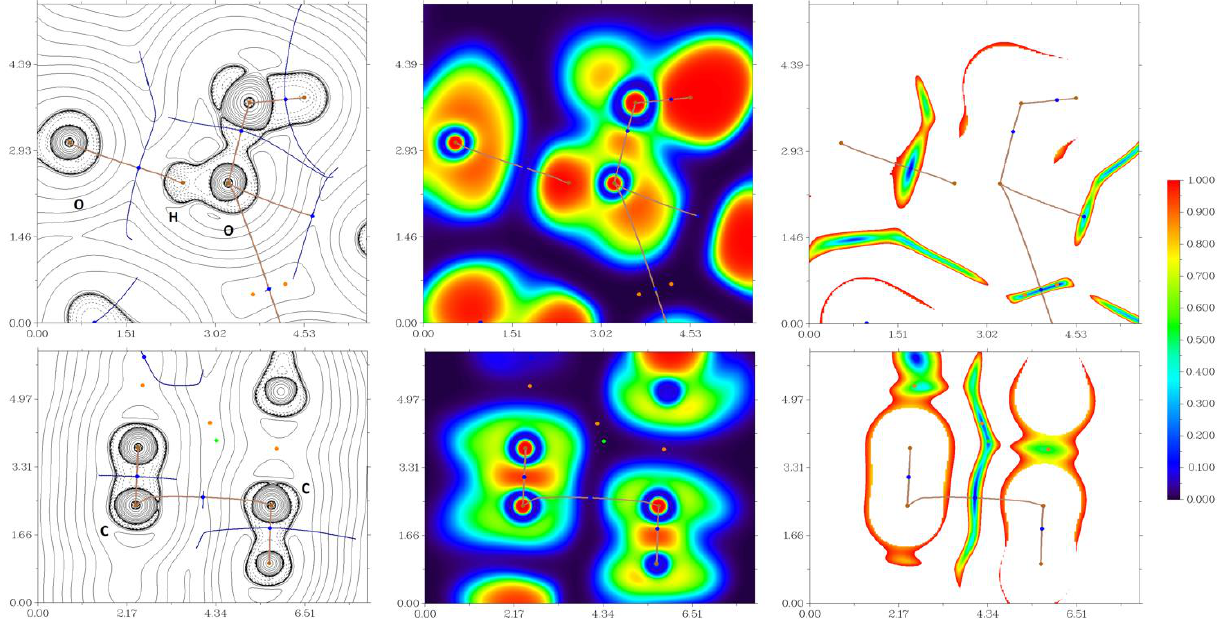
Figure 6. Contour line diagrams of the Laplacian of electron density distribution ∇ 2 ρ ( r ) and selected zero-flux surfaces (left panels), visualization of electron localization function (ELF, center panels) and reduced density gradient (RDG, right panels) analyses for hydrogen bond O–H ··· O (top) and stacking interactions (bottom) in the X-ray structure of 1 . Bond critical points (3, − 1) are shown in blue, nuclear critical points (3, − 3)—in pale brown, ring critical points (3, +1)—in orange, cage critical points (3, +3)—in light green, length units—Å, and the color scale for the ELF and RDG maps is presented in a.u. Table 4. Values of the density of all electrons —ρ ( r ), Laplacian of electron density — ∇ 2 ρ ( r ) and ap-